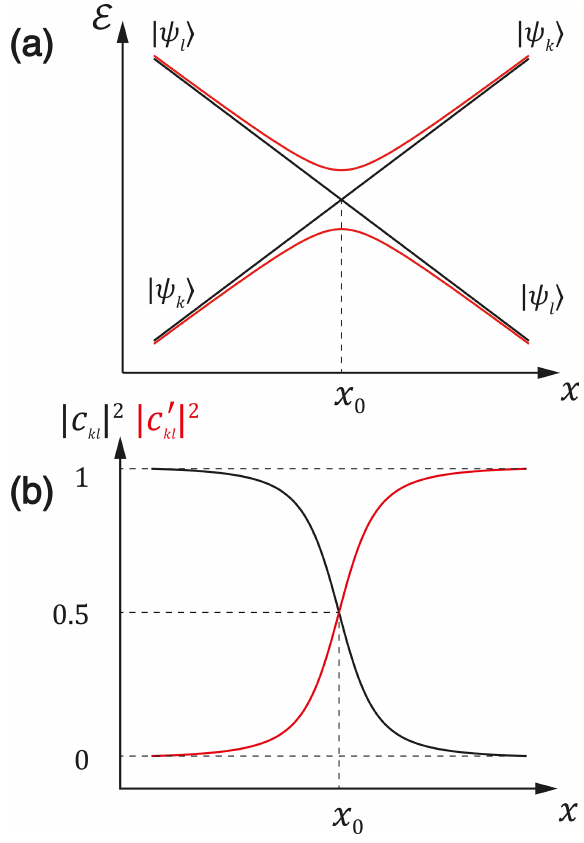
Figure 1. (a) Representation of an LC and LAC. The black lines represent the energies of the diabatic states, which have an LC. The red lines show the adiabatic energy levels. (b) The mixing coeffi- cients introduced in Eq. (3) in the LAC